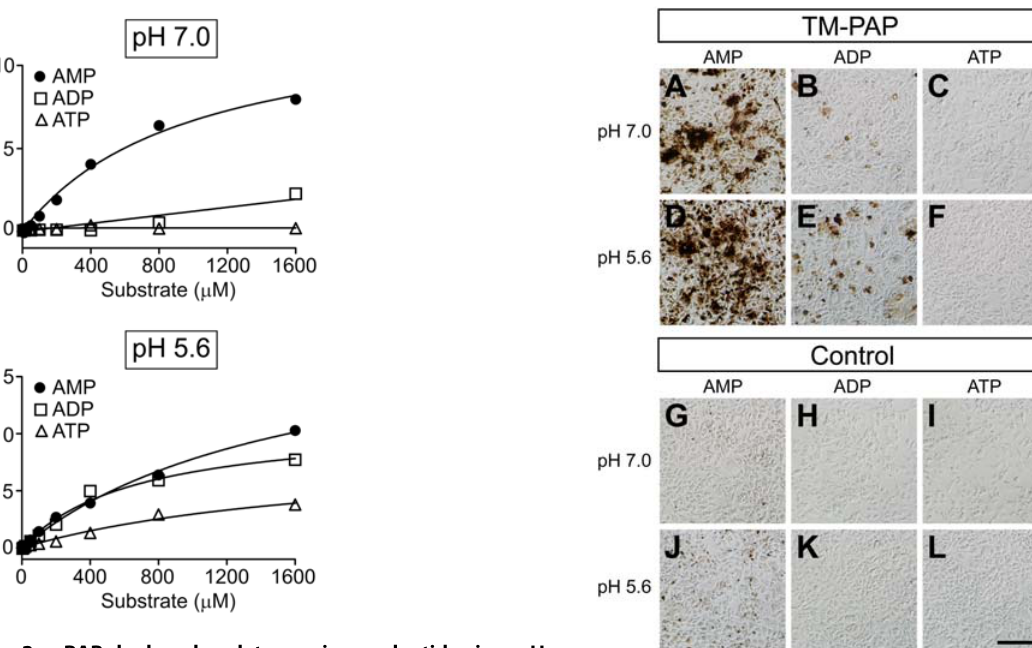
Figure 3. mPAP dephosphorylates purine nucleotides in a pH- dependent manner. Plot of initial velocity at the indicated concentrations of AMP, ADP and ATP at (A) pH 7.0 and (B) pH 5.6. Reactions (n=3 per point) were stopped after 3 min. Inorganic phosphate was measured using malachite green. All data are presented as means 6 s.e.m. Error bars are obscured due to their small size.